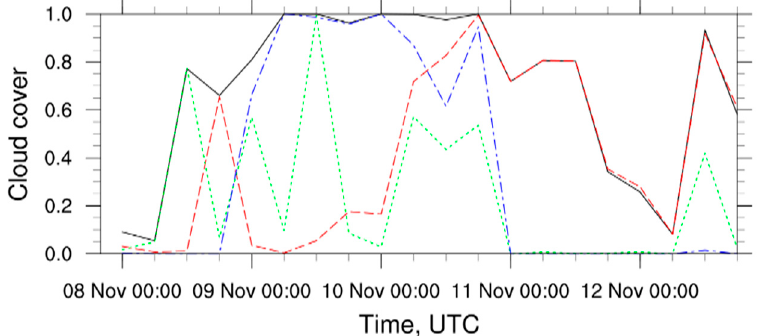
Figure 4. Cloudiness at the Sheveluch volcano during the 1964 eruption according to the ERA-40 reanalysis data: black solid line—total cloud cover; red dashed line—low cloud cover; green dotted line—medium cloud cover; blue dash-dotted line—high cloud cover.